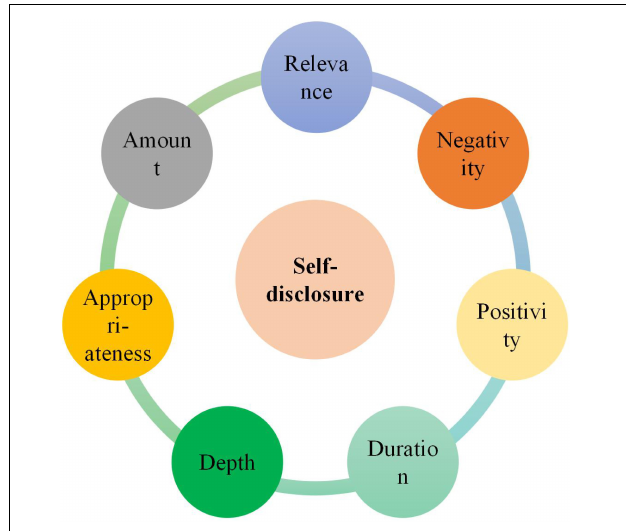
FIGURE 1 | The dimensions of